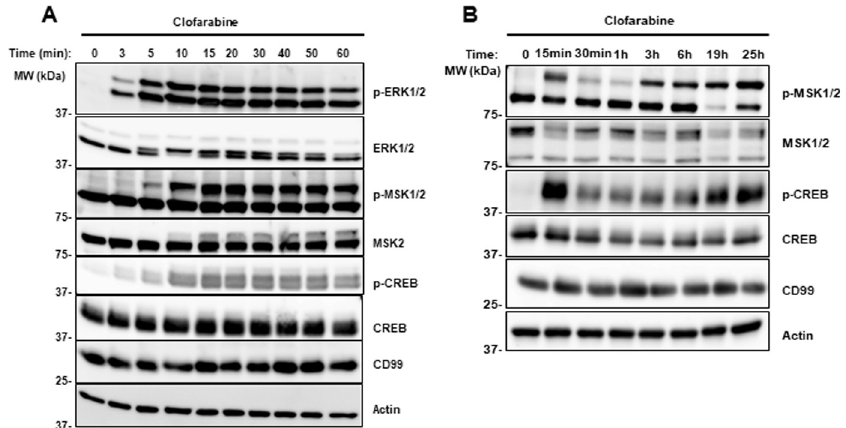
Fig 4. Time course of phosphorylation changes after clofarabine treatment of STA-ET-7.2 cells. (A) STA-ET-7.2 cells treated with 0.5 μ M clofarabine and total cell lysates collected at different time points. Western blot results showed increased phosphorylation starting as early as 3 minutes; (B) phosphorylation changes were sustained through 25 hours with a reduction around one hour. Actin was used as loading control.